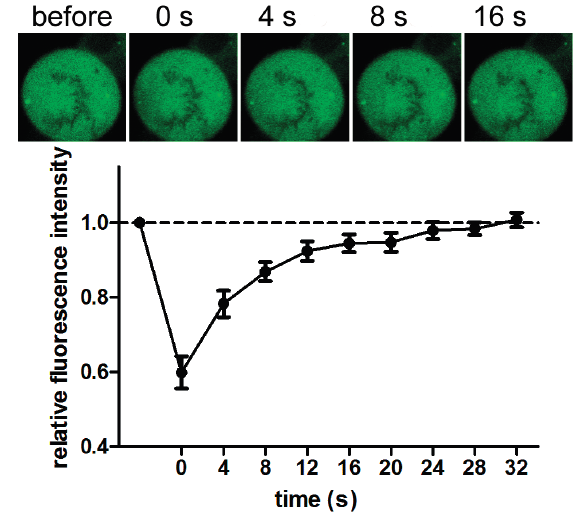
Figure 2. Fluorescence recovery after photobleaching (FRAP) of centrosomal GFP-MLH3 foci. Data shown represents eight independent measurements. Error bars represent the standard error of the